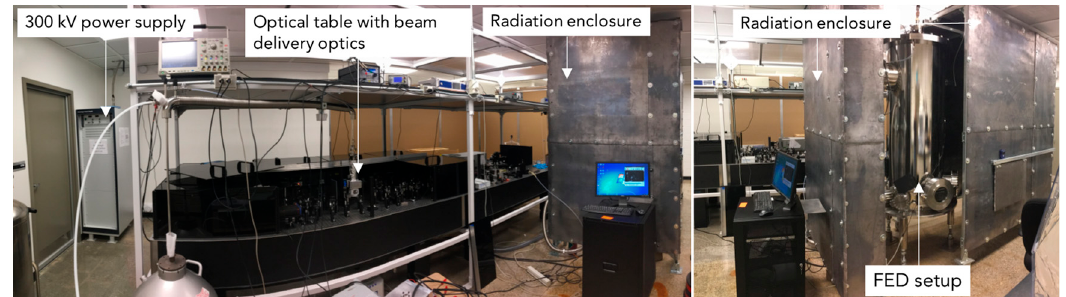
Figure 14. 300-kV DC FED apparatus at the Ultrafast electron Imaging Lab ( UeIL). Left panel displays the 300-kV power supply, and the optical table with beam transport optics. Right panel shows the 300-kV FED instrument surrounded by a radiation enclosure.